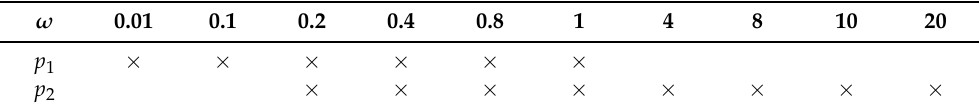
Table 1. Frequency-band allocation that minimises u i